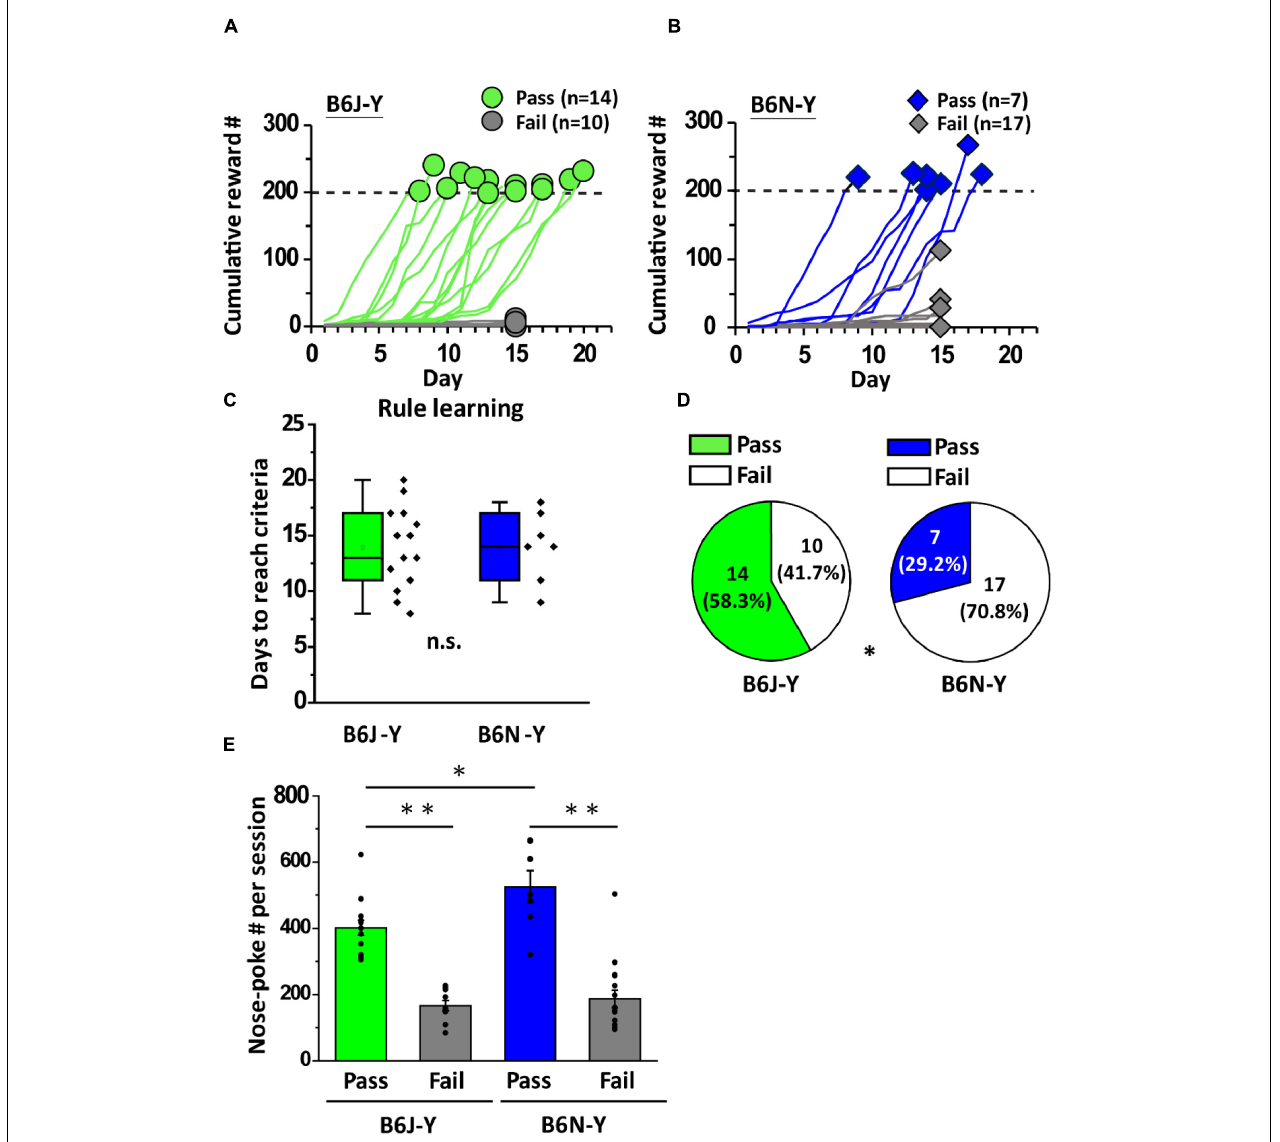
FIGURE 2 | B6J and B6N mice during young adulthood had distinct pass percentages of rule learning. (A,B) Curves of cumulative reward number by day of B6J mice (green lines) and B6N mice (blue lines). Green circles and blue rhombuses represent cumulative reward numbers in the last session of rule learning. Dash lines mark the required number of rewards to pass rule learning. (C) Box plots of days to reach criteria of the B6J (green) and B6Y (blue) mice. (D) Pie charts showing B6J-Y and B6N-Y mice that passed or failed rule learning. (E) Average nose-poke number per session of the mice belonging to different substrains and behavioral groups. ∗ p < 0.05. ∗∗ p < 0.01. n.s.,